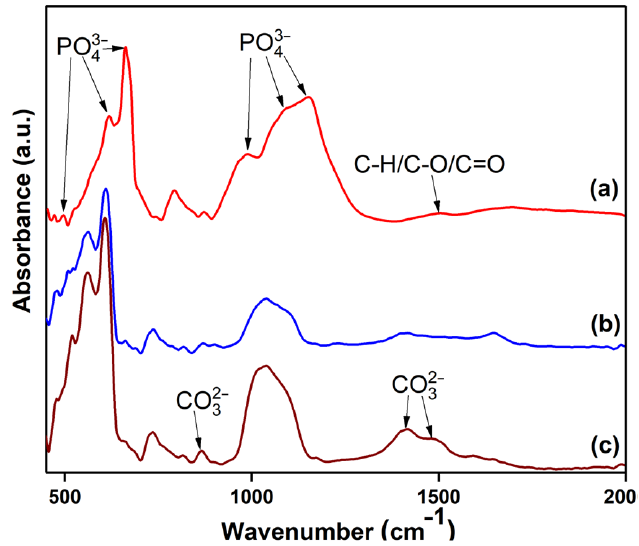
Figure 1. Absorbance ATR-FTIR spectra of ZnHApC ( a ), ZnHApC-7D ( b ), and ZnHApC-14D ( c )